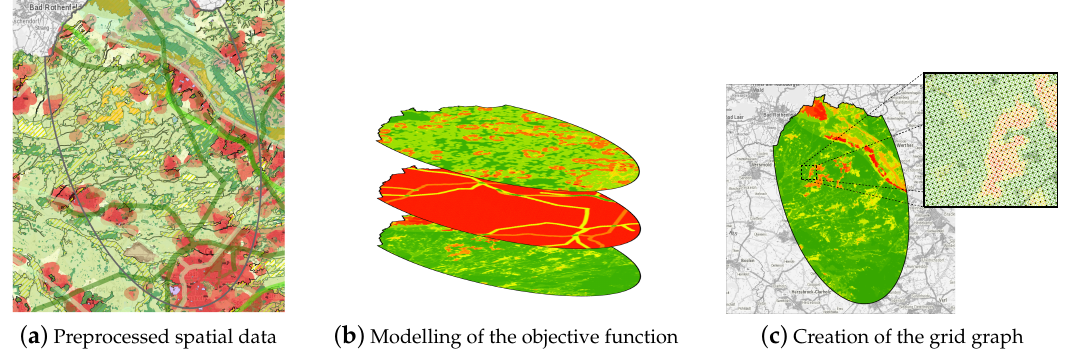
Figure 3. Creation of the grid graph: ( a ) spatial data is preprocessed using GIS; ( b ) objective function is modelled (visualisation of three exemplary weight layers) and ( c ) view of the resulting graph structure. Colour mapping from high values (red) to low values (green) is